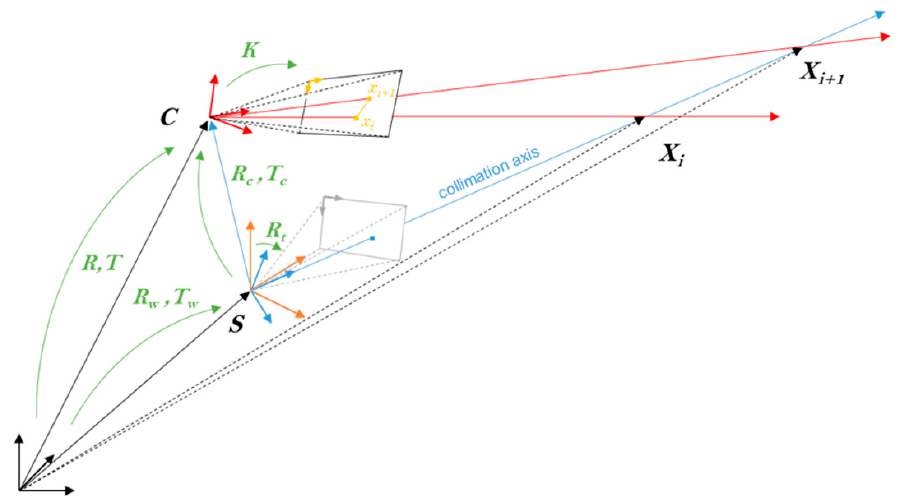
Figure 10. Transformations needed to convert image coordinates into theodolite angles and vice versa [8].